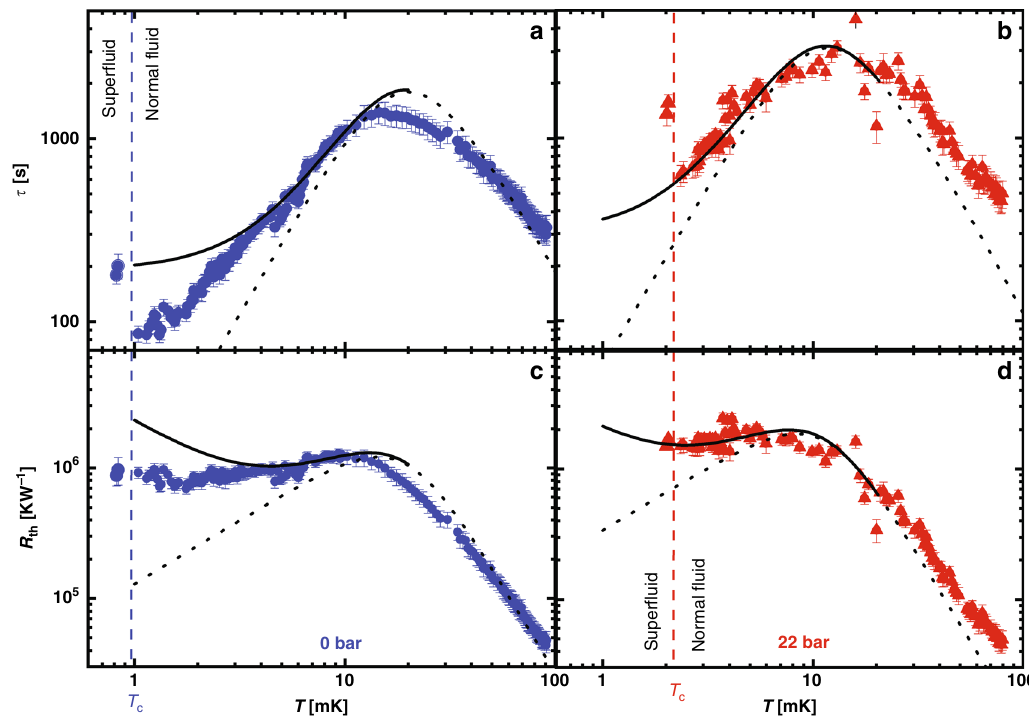
Fig. 3 Normal-state thermal relaxation time and resistance. The measured thermal relaxation times a and b , and calculated thermal resistances c and d at 0 (blue circles) and 22 bar (red triangles) in the normal state, showing a crossover from boundary limited behavior at high temperature to a low temperature behavior that is different from that expected for bulk. The error bars represent the standard deviation of the fi ts to τ . Also shown is the calculated bulk behavior: black dotted lines for the bulk fl uid thermal resistance in the channel in parallel with thermal boundary resistance. The black solid lines show behavior expected for an isotropic distribution of point scatterers in the channel that would give rise to a limiting mean free path of 1.1 μ m. T c is marked by vertical dashed lines in blue (0 bar) and red (22 bar). The bulk calculations reference measured speci fi c heat 63 , thermal conductivity 34 , and thermal boundary resistance 61 .